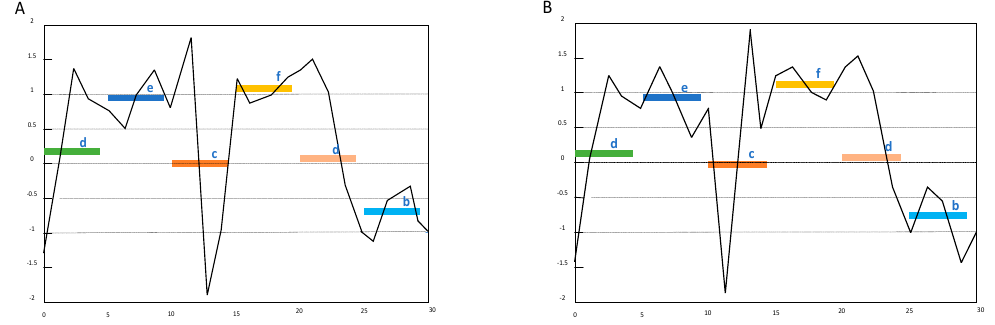
Figure 1. Financial time series A and B have the same SAX symbolic representation ‘decfdb’ in the same condition where the length of time series is 30, the number of segments is 6 and the size of symbols is 6. However, they are different time series.